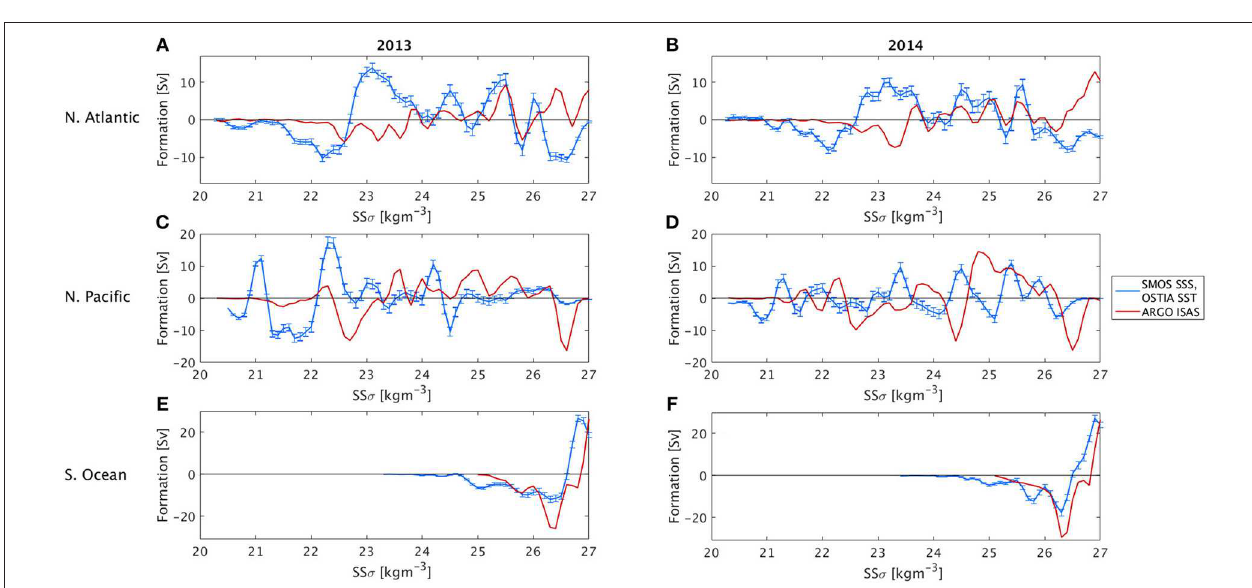
FIGURE 9 | The geographic distribution of the water mass formation peak in the North Atlantic for the years 2012 (A–D) , 2013 (E–H) , and 2014 (I–L) , and for the respective seasons winter (JFM), spring (AMJ), summer (JAS) and autumn (OND). The approximate geographic location of the EDW is shaded in yellow (Worthington, 1958; Hanawa and Talley, 2001 ).